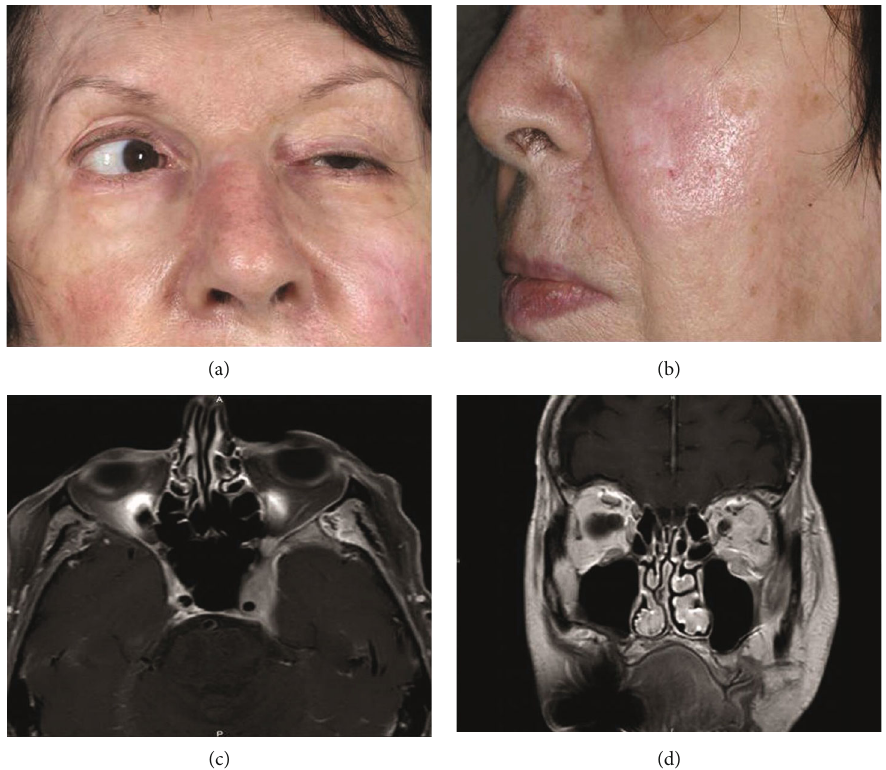
Figure 1: (a) Complete left ophthalmoplegia and left upper-eyelid ptosis. (b) Actinic keratosis of the left cheek. (c) Facial and orbital MRI: sagittal view: in fi ltrating lesion extending through the left infraorbital canal orbital apex and the left cavernous sinus with perineural in fi ltration. (d) Facial and orbital MRI: coronal view: in fi ltrating left orbital process started from the left cheek with a large amount of